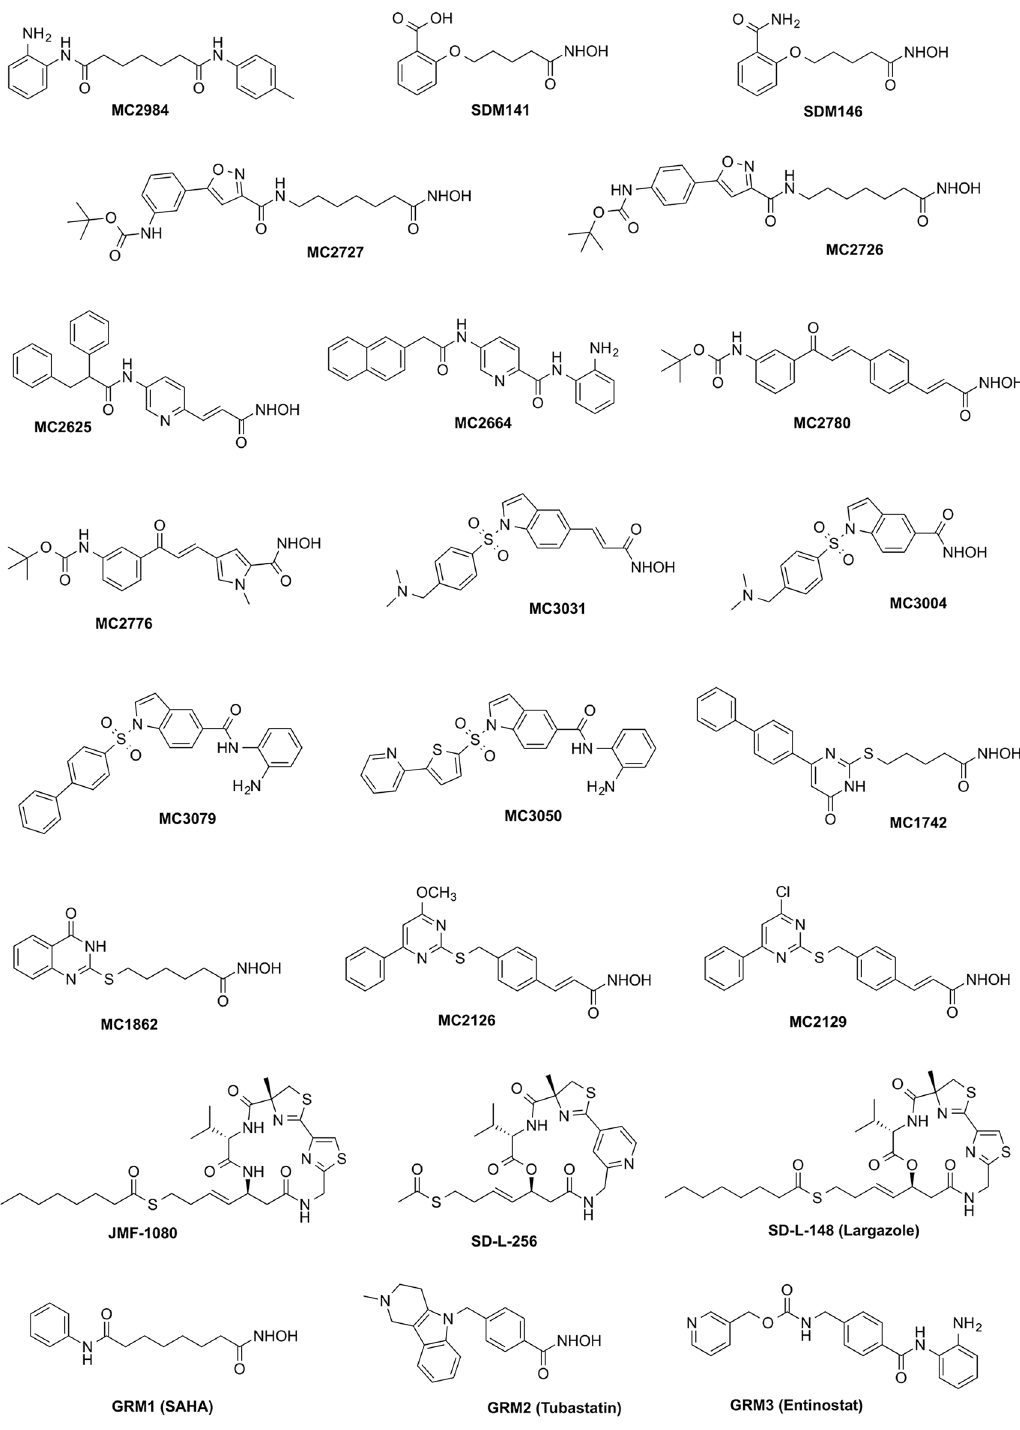
Fig 1. Chemical structures of compounds used in parasite screening assays.